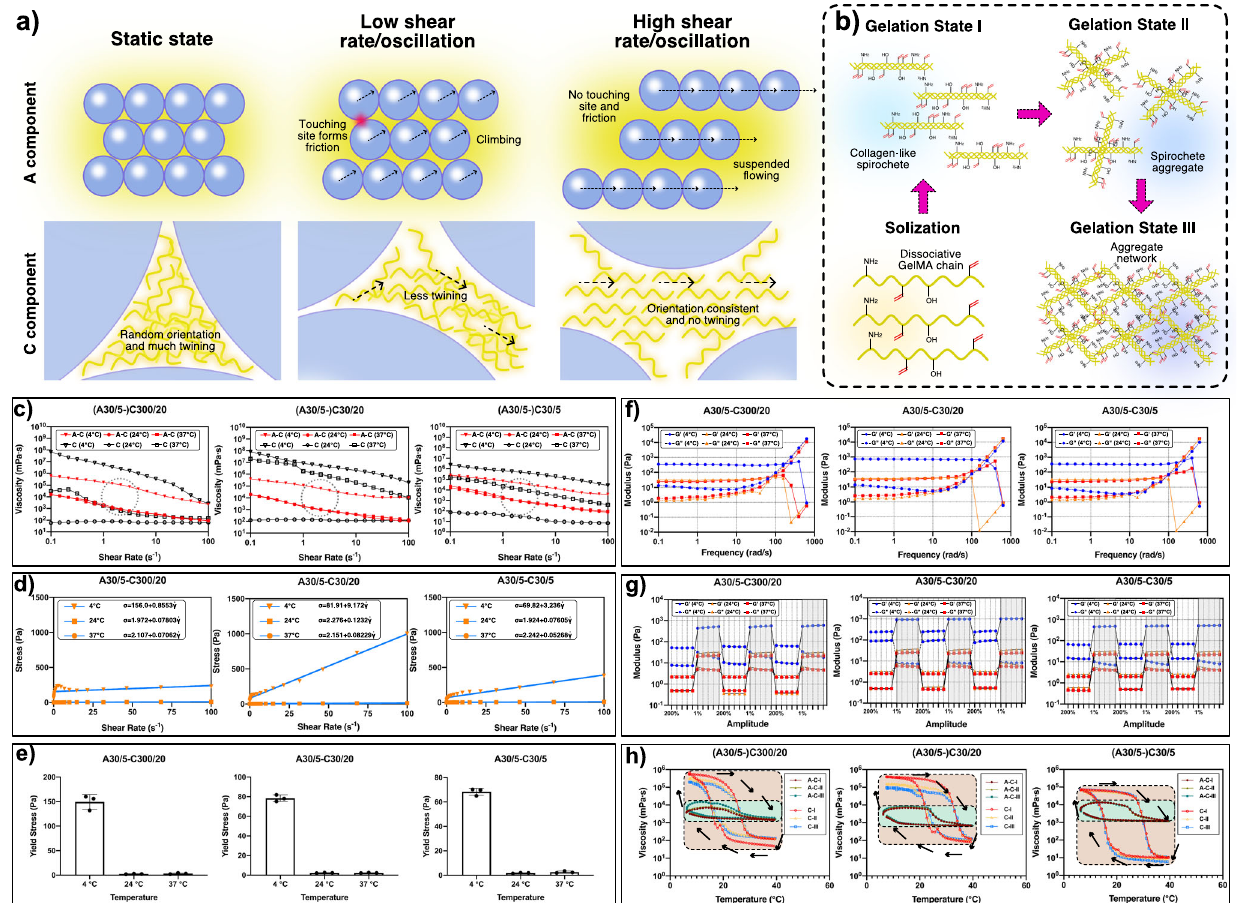
Fig. 3 Rheological robustness testing of A – C bioink. a The mechanism of the shear-thinning feature of A – C bioink. b The mechanism of the GelMA precursor solution sol – gel transferring. c Flow sweep testing. d Fitting with Bingham fl uid model. e Yield stress. ( n = 3 independent experiments. Data are presented as mean value ± SD.) f Oscillation frequency testing. g Thixotropy testing. h Recycled fl ow temperature ramp